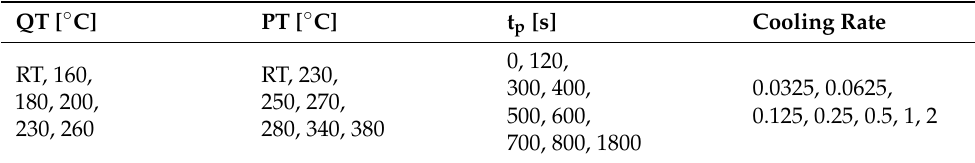
Figure 2. Schematic illustration of the Q&P process used in this study. M s is the martensitic start temperature, M f is the martensitic finish temperature, QT is the quenching temperature, PT is the Partitioning temperature, t h is the heat-up time, t p is the partitioning time. Table 2. Q&P process parameters range used in this